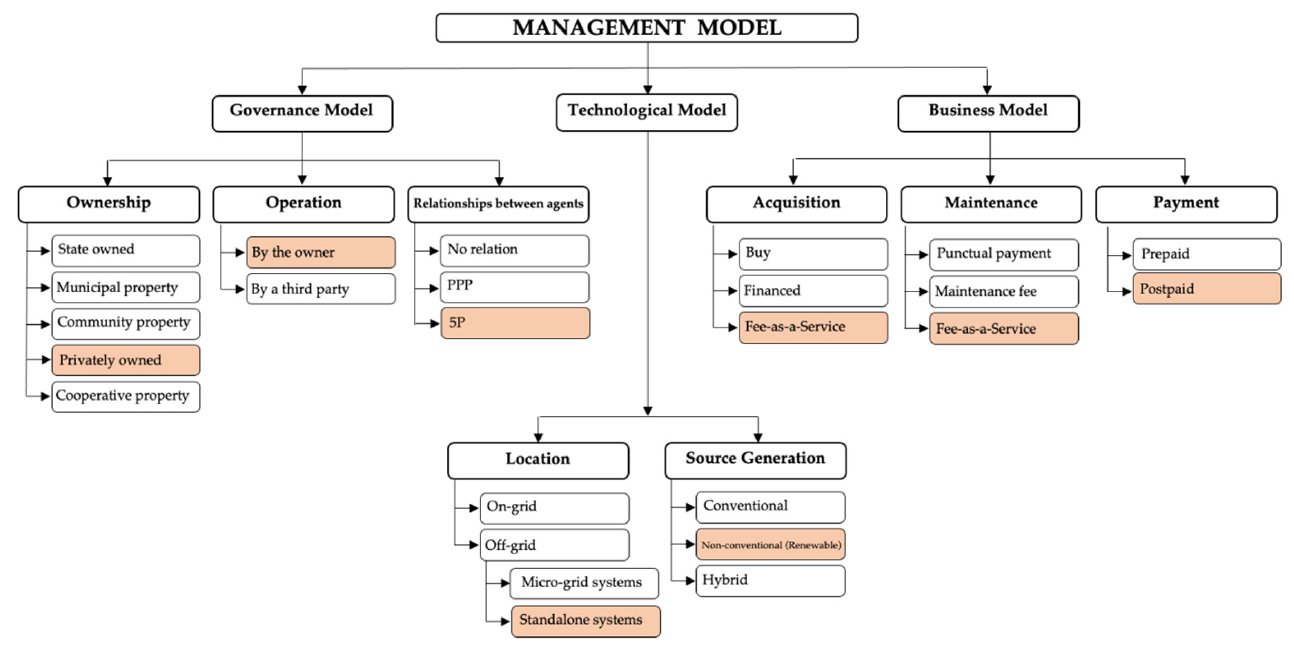
Figure 2. Configuration of the management model of the “Luz en Casa Cajamarca” project.